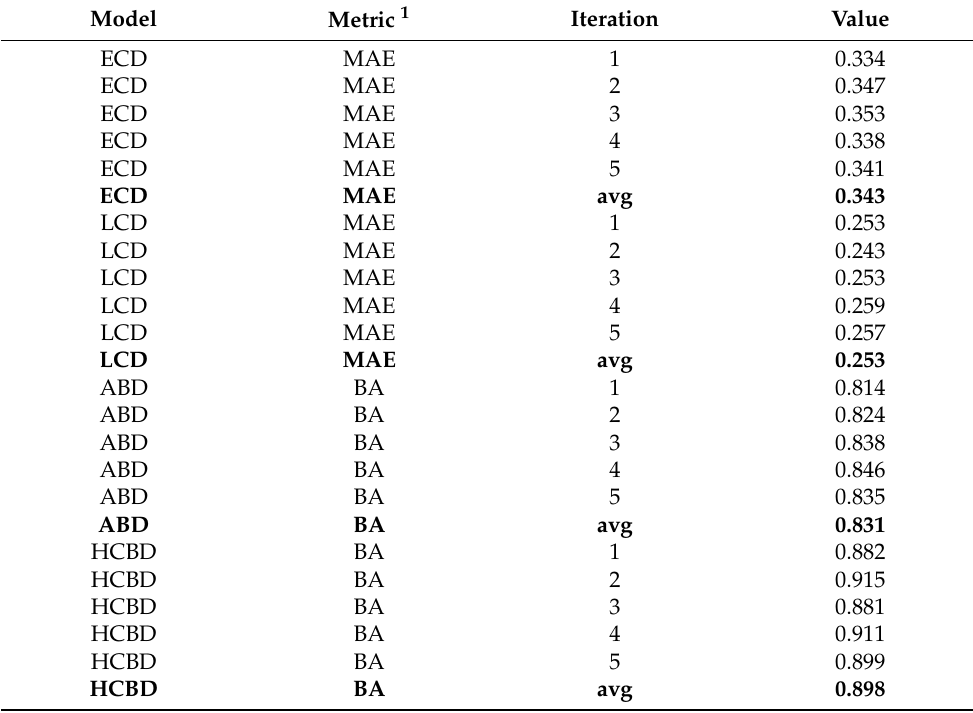
Table 3. Results for the internal